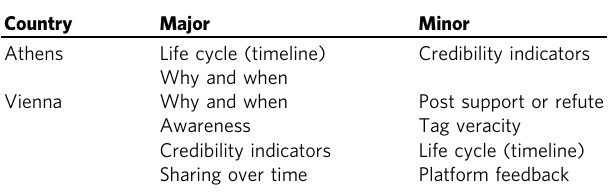
Figure 4 aggregates policymakers ’ preferences in the two countries (equally weighted).